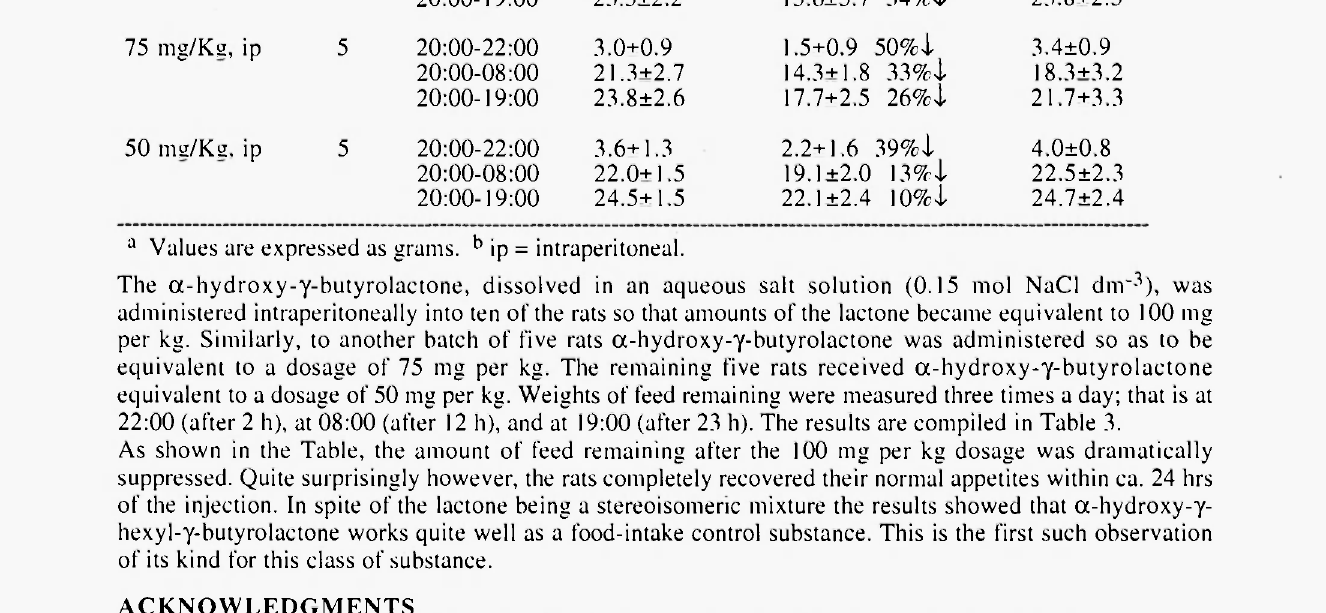
Food-Intake for Rats Receiving Administration of a-Hydroxy-y-Hexyl-Y-Butyrolactone TREATMENT (n)